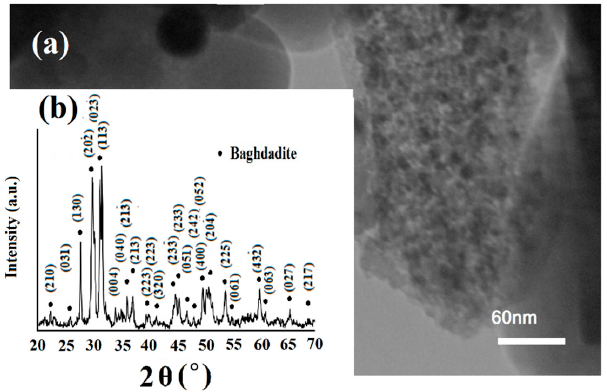
Figure 1. ( a ) TEM micrograph and ( b ) XRD patterns of baghdadite nanopowder fabricated by sol–gel